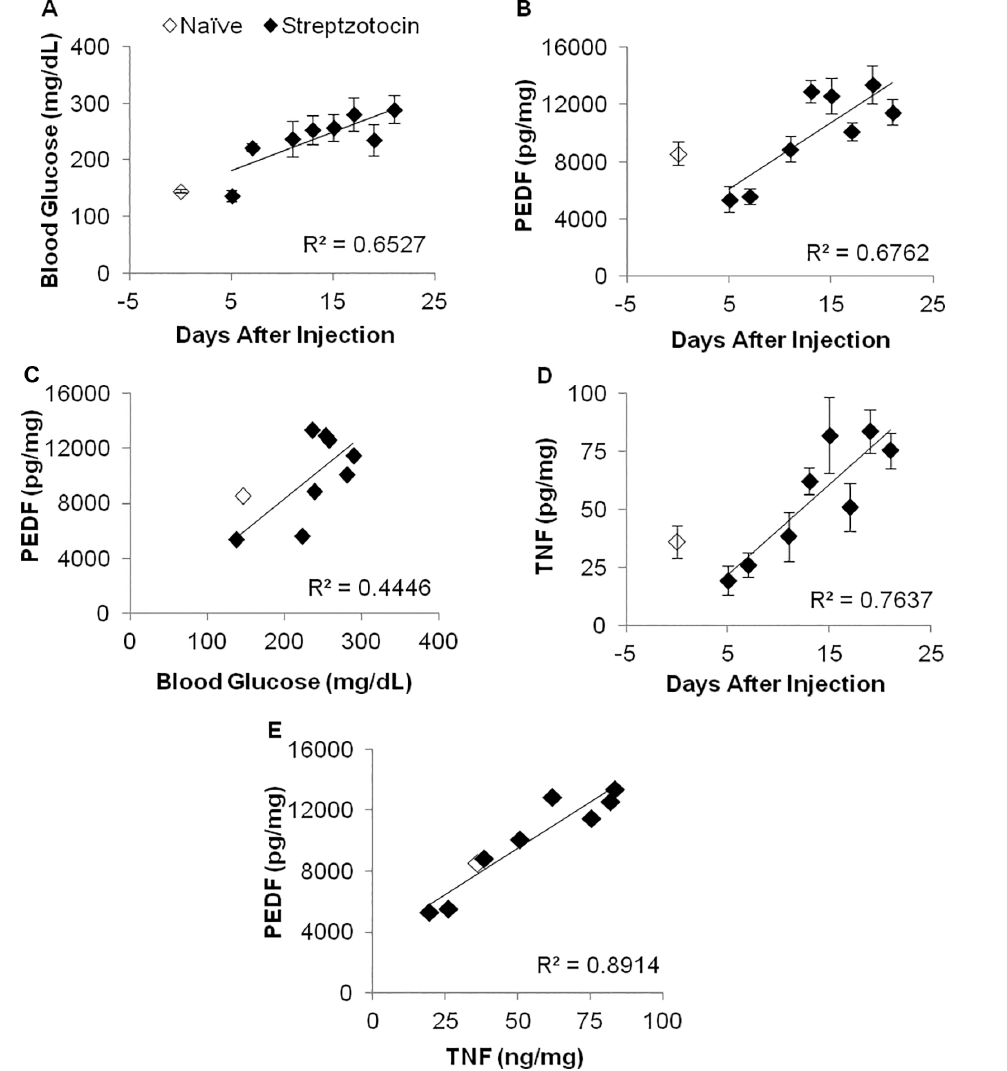
Figure 1. Blood glucose, pancreatic TNF and pancreatic PEDF are elevated in a low-dose streptozotocin model of T1D. (A) Blood glu- cose, (B) PEDF and (D) TNF levels increase over time in mice streptozotocin-induced type 1 diabetes. Levels of PEDF and TNF and were monitored in blood and pancreas over time. Pancreatic PEDF levels are correlated with (C) blood glucose and (E) pancreatic TNF levels. (A) Days: 0 (n = 84); 7 (n = 62); 5, 11, 13, 15, 17, 19 and 21 (n = 7). (B, D) n = 7. (C, E) Data are shown as mean ± SEM with a linear regression fit model (n =